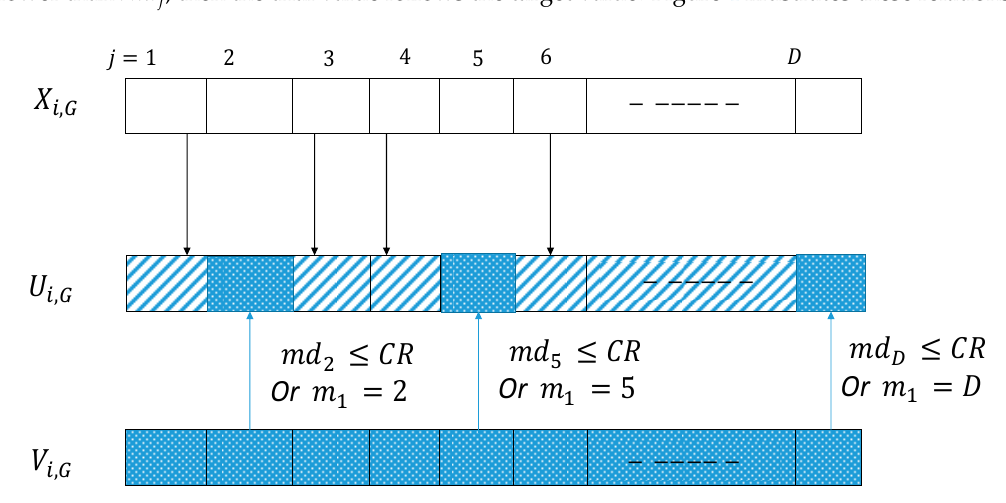
Figure 4. Generation of D-dimensional trial vector after crossover operation in DE algorithm.